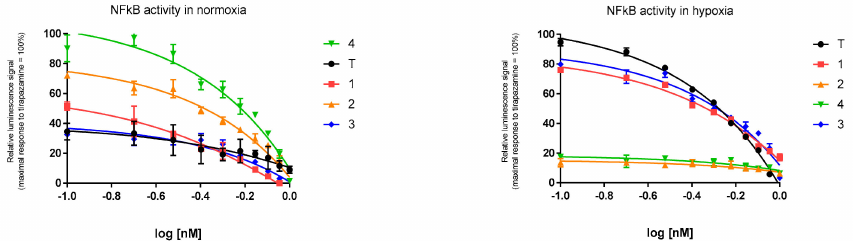
Figure 4. NF- κ B transcriptional activity in T47D cells expressed by luciferase reporter gene assay after exposure to tested benzimidazole derivatives 1–4 and tirapazamine (T) for 24 h. Data have been normalized to tirapazamine and compound 4 maximal response for hypoxic and normoxic conditions, respectively; data represent significant di ff erence at p ≤ 0.05 (n = 3, mean ±